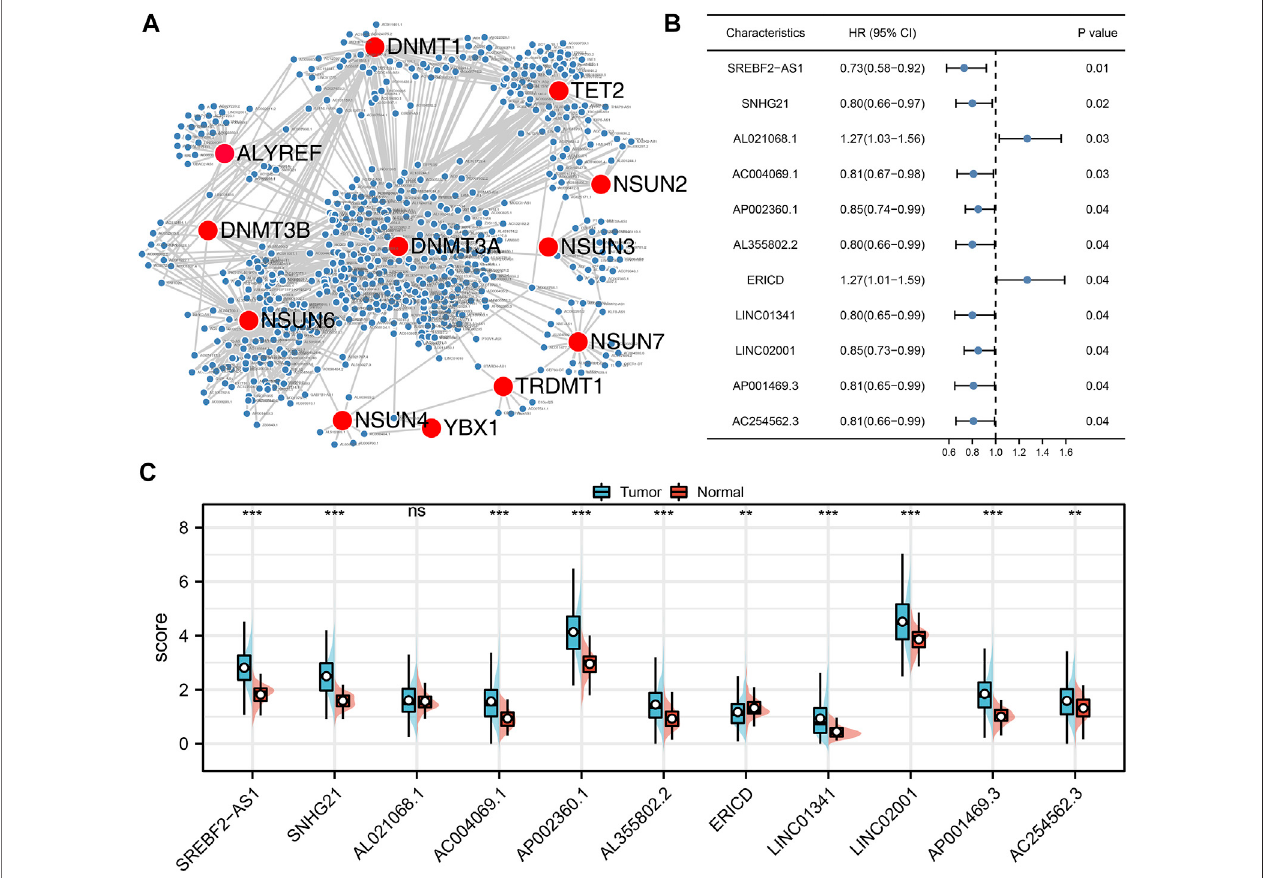
FIGURE 1 | Identi fi cation of the m5C-related lncRNAs. (A) Co-expression network of m5C genes and the m5C-related lncRNAs; (B) Univariate Cox regression analysis was performed to identify the prognosis-related lncRNAs; (C) Expression level of SREBF2-AS1, SNHG21, AL021068.1, AC004069.1, AP002360.1, AL355802.2, ERICD, LINC01341, LINC02001, AP001469.3, and AC254562.3 in normal and tumor tissue.